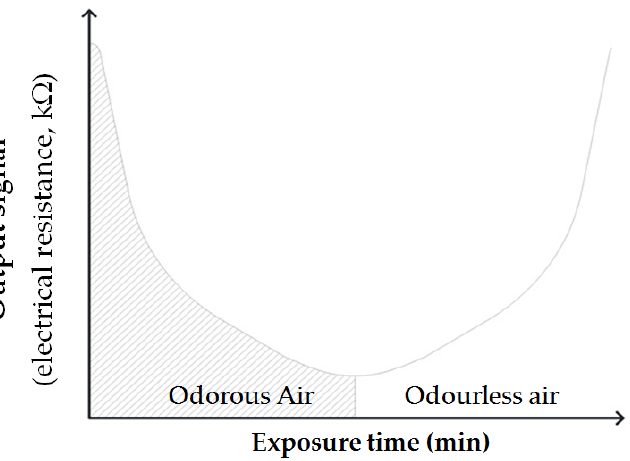
Figure 1. Electrical signals trend with respect to time at odour and odourless air exposure.